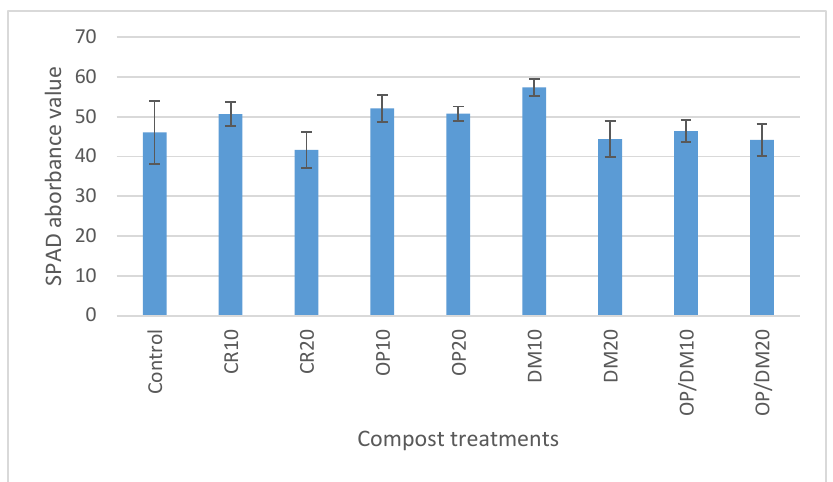
Figure 9. Number of leaves of bell pepper plants as affected by different compost sources and rates. Error bars represent ± standard error ( P = 0.08, n = 6).